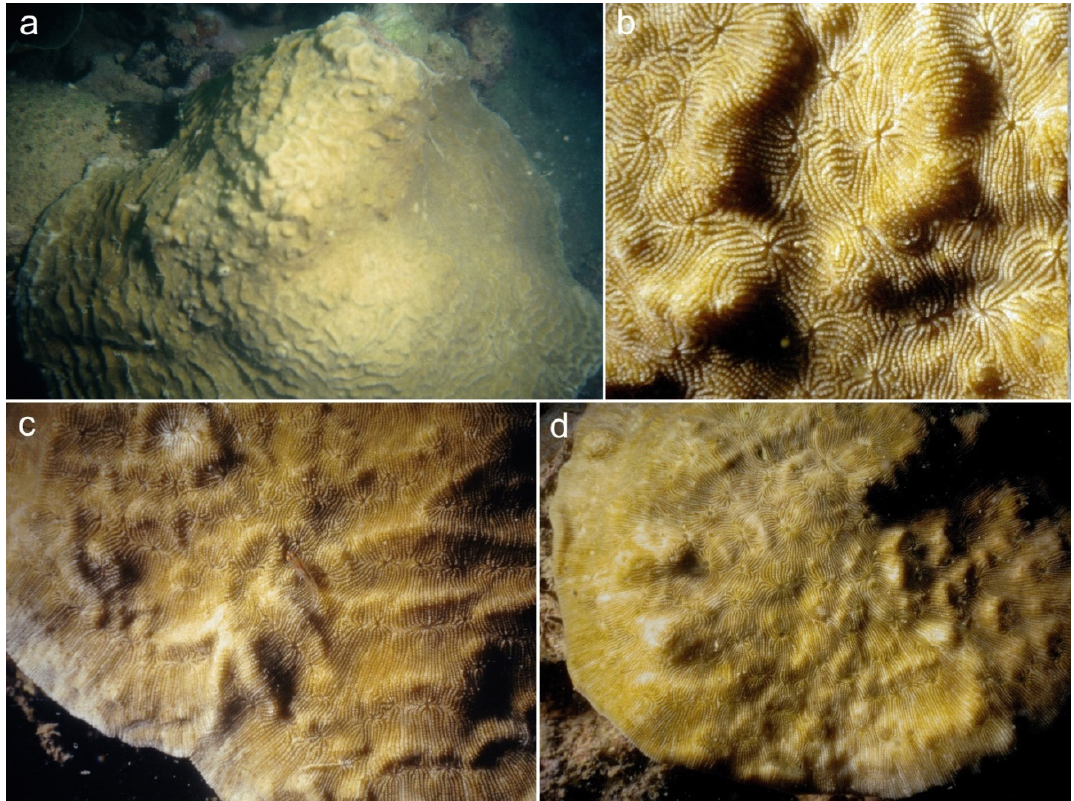
Figure 1. Coscinaraea marshae in Sarabua Bay, Siberut Island, West Sumatra. ( a ) Large specimen, ca. 50 cm across. ( b ) Same specimen; close-up. ( c ) Smaller specimen, close-up. ( d ) Smallest specimen.